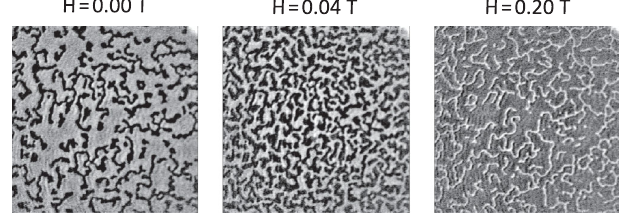
FIG. 12. X-ray microscopy images of a magnetic electrode at different applied perpendicular fields: 0, 0.04, and 0.2 T. The images are selected from a magnetic-hysteresis loop shown in full in video 1 [28]. The image sizes are all 5 (cid:1) 5 (cid:1) m 2